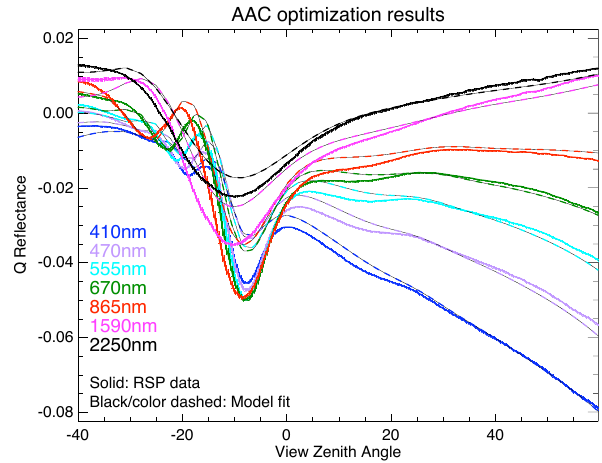
Solid: RSP data Black/color dashed: Model fit